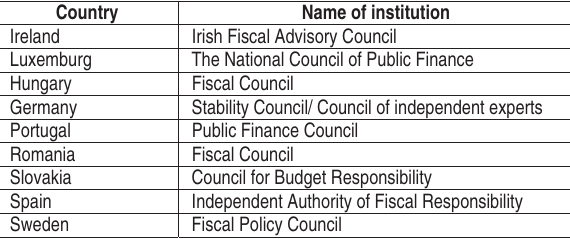
Table 2. Independent fiscal